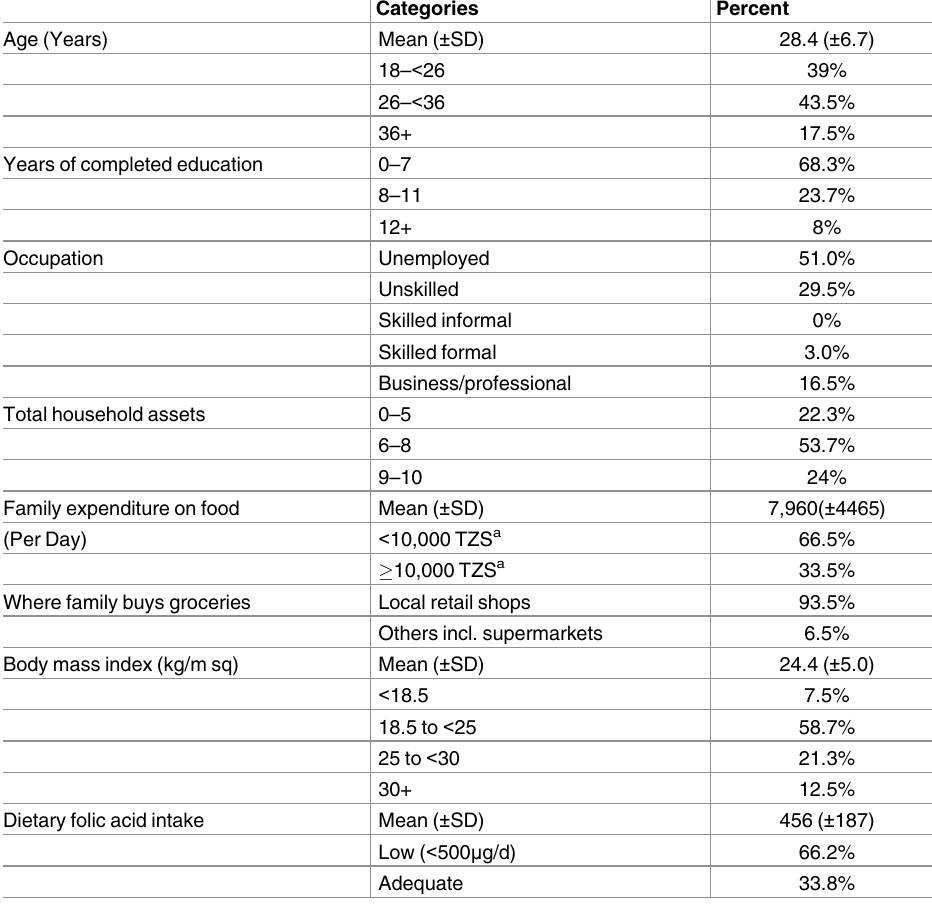
Table 2. Basic Characteristics of women at baseline (n =